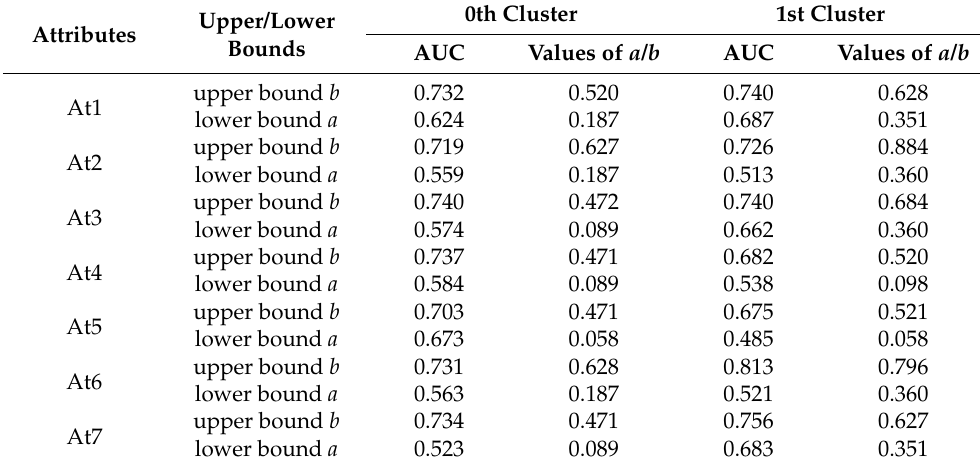
Table 5. The summary of the AUC values and bounds of information granules ( α = 0.5).